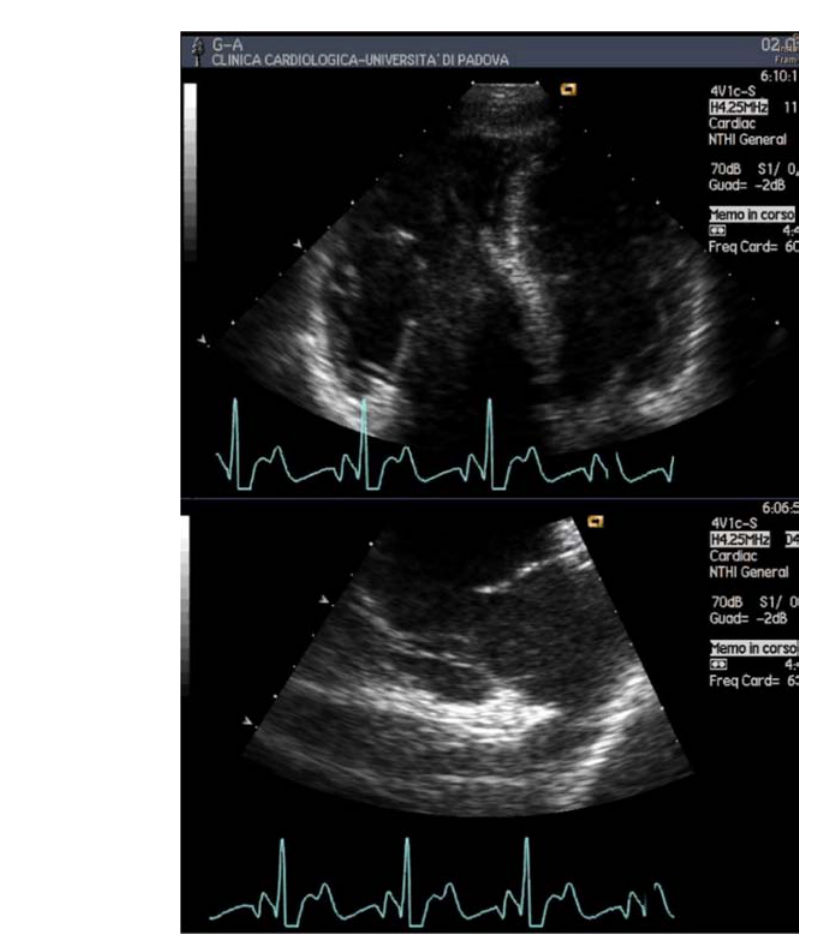
Figure 6. Echocardiography of a patient with arrhythmic cardiomyopathy. Upper panel shows an apical 4 chamber view with dilated anuerysmal right ventricle. Lower panel shows a modified short axis left paraternal view to visualize the subtricuspid area which shows a localized aneurysm. (Images courtesy of MP Marra, MD, University of Padua,